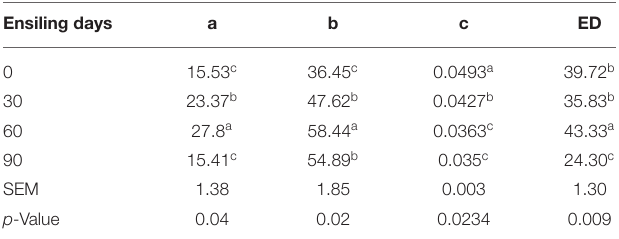
TABLE 9 | Effect of ensiling duration on the rapidly degradable nutrient (a, %), slowly degradable nutrient (b, %), effective degradation rate (c), and the effective degradability (ED, %) of forage rape silage.